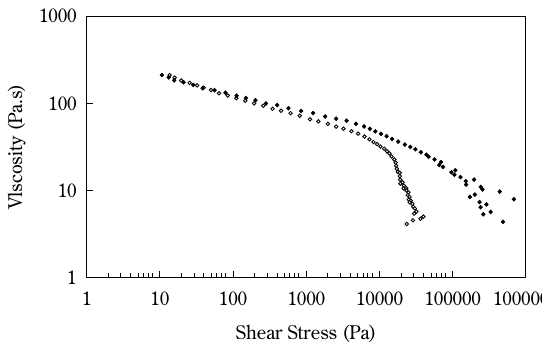
Fig. 5 Viscosity as a function of shear stress for a commercial tooth- paste sample. The data were collected using a vane tool in either a smooth walled cup [open symbols] or a cup with a roughened surface [filled symbols]. The different response of these two data sets can be attributed directly to sample slip at the smooth cup surface; such slip may lead to the erroneous interpretation of a yield